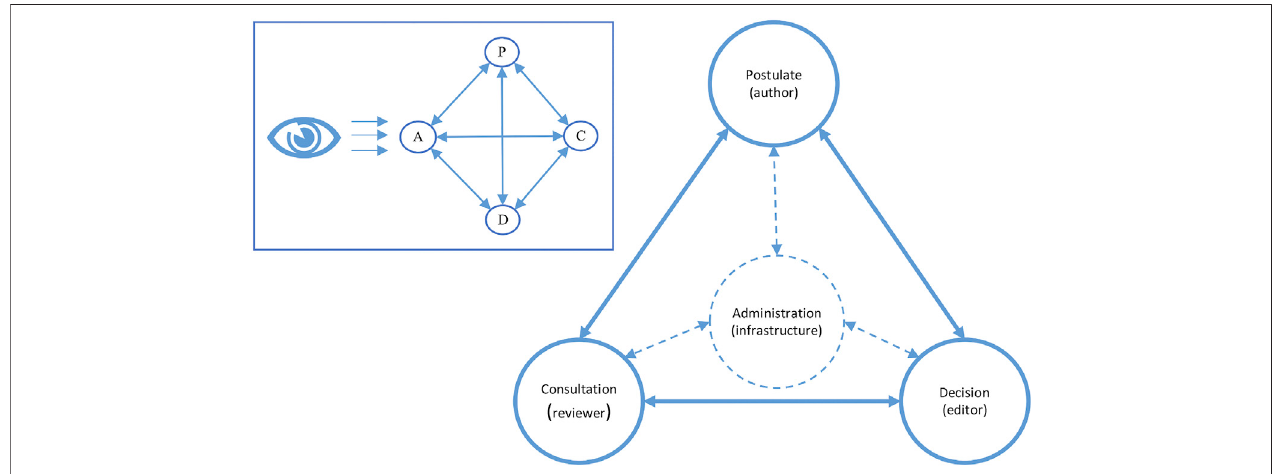
FIGURE 7 | The process elements postulation (P), consultation (C), decision (D) and administration (A), adapted after Schendzielorz and Reinhart (2020), are mutually connected with each other, but seen by the infrastructure from the standpoint of administration. Thus, it is rendered invisible as distinguishable component.